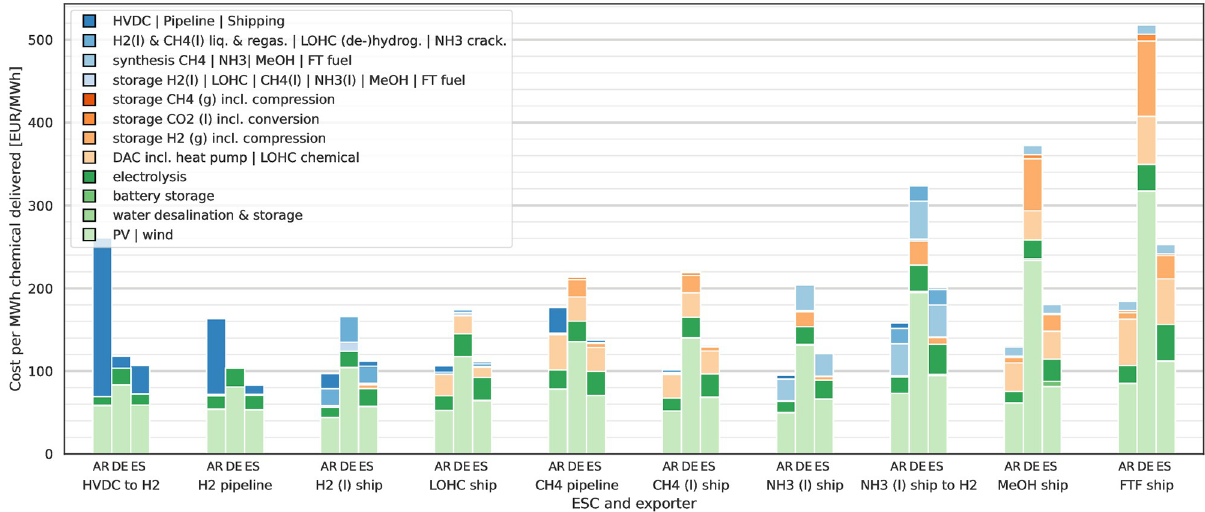
Fig 6. Cost composition of selected ESCs for 2030 at 10% p.a. WACC. Simpler, less energy intensive ESCs are favourable for short distances, e.g. domestic sourcing from DE and imports from ES, where low costs associated with transport can compensate high RES costs. More complex, energy intensive ESCs allow long distances exports, e.g. from AR, to become cost competitive due to lower RES costs and trading more complex molecules with higher energy intensity for lower transport cost.